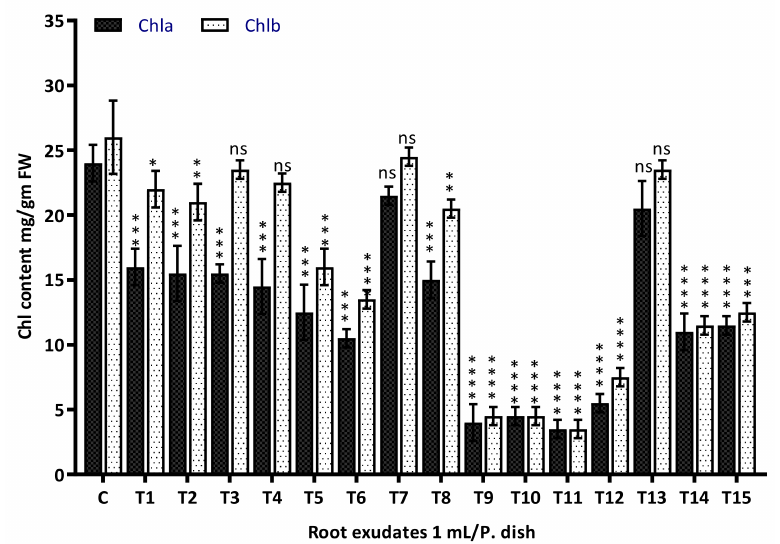
Figure 2. Effects of root exudates on chlorophyll a and chlorophyll b of T. aestivum shoot in Petri dishes cultivation. Different numbers of signs (*) indicate significant differences among the different root exudates of the tested weeds at the p < 0.05 level. ns = not significant. C = Control, T1: Centella asiatica , T2: Rotala indica , T3: Solanum nigrum , T4: ommelina benghalensis , T5: Marsilea quadrifolia , T6: Ageratum conyzoides , T7: Cynodon dactylon, T8: Spilanthes acmella, T9: Heliotropium indicum, T10: Leucas aspera , T11: Phyllanthus niruri , T12: Sida acuta , T13: Mikania micrantha , T14: Polygonum hydropiper , T15: Physalis heterophylla .